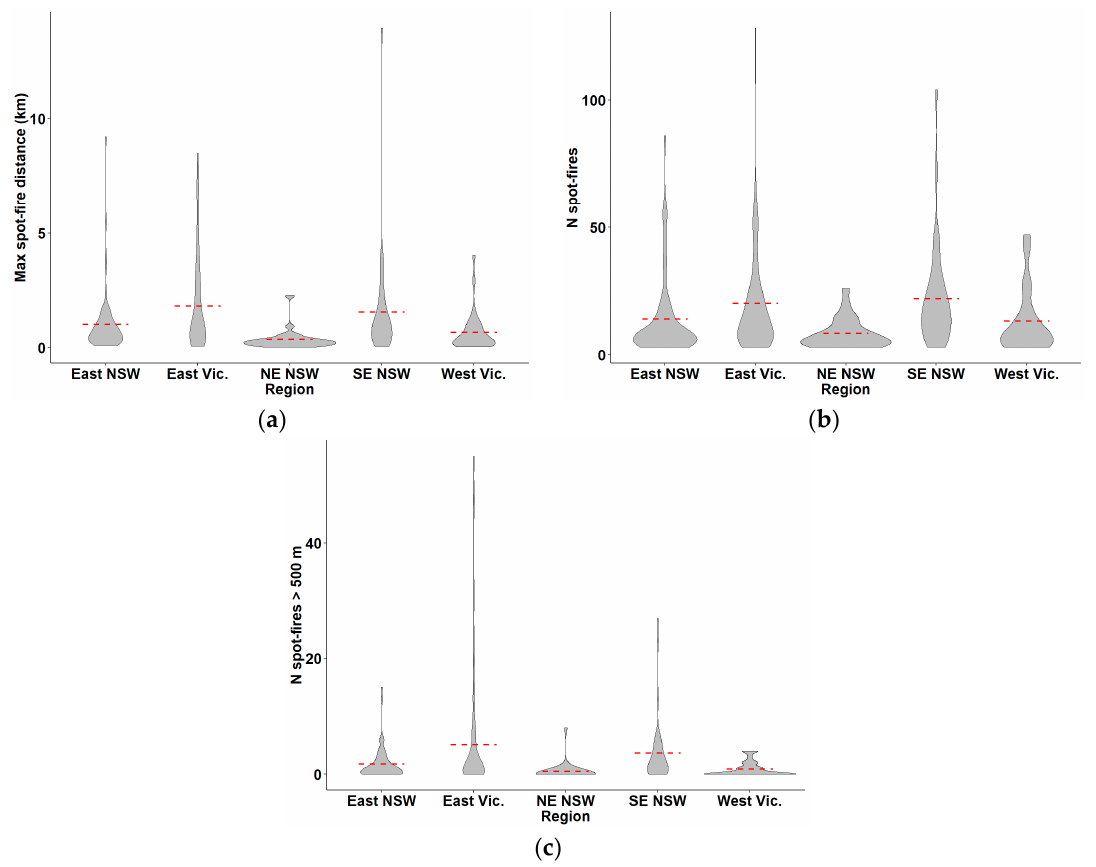
Figure 10. Violin plots of region vs. maximum spot fire distance ( a ), number of spot fires ( b ), and